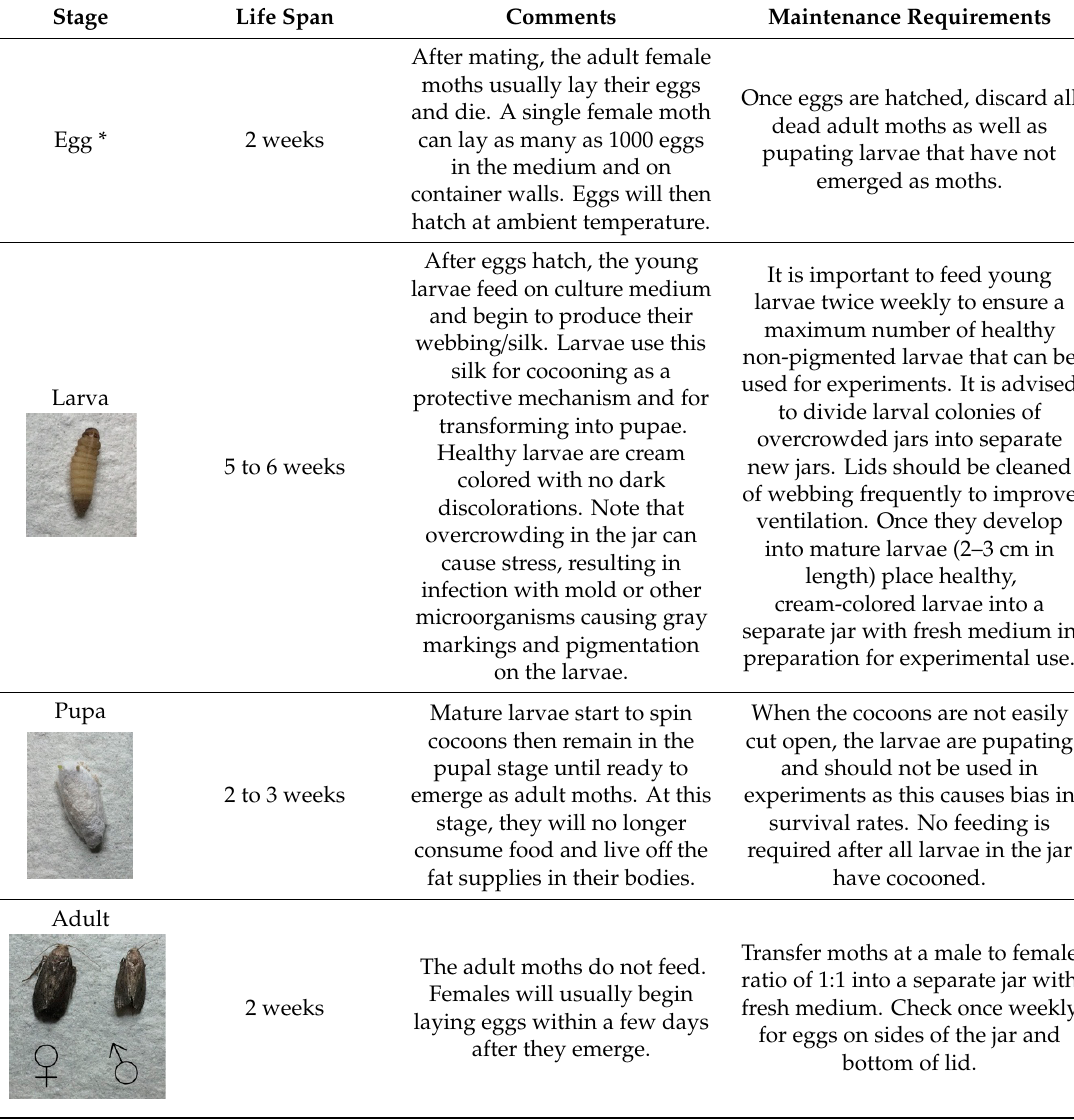
Table 1. Summary of the life cycle of Galleria mellonella and maintenance requirements at each stage.